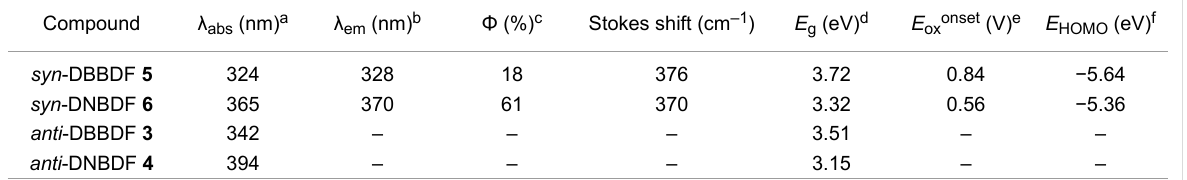
Table 1: Photophysical and electrochemical properties of syn / anti -DBBDFs and DNBDFs. Compound